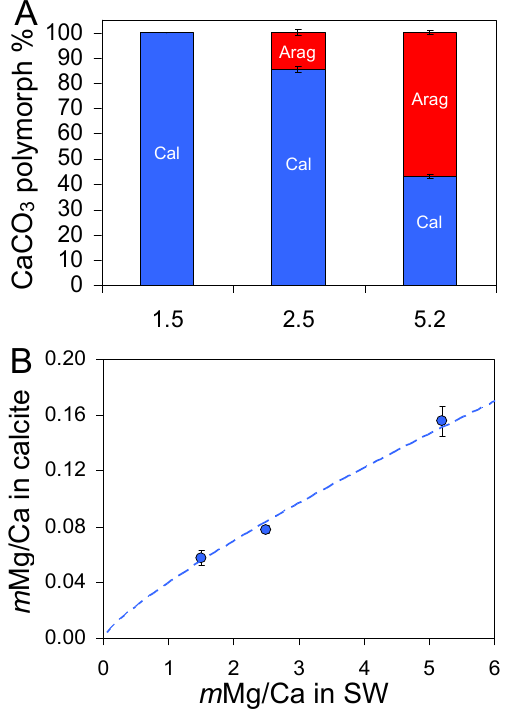
Fig. 28. Mineralogy and geochemistry of CaCO 3 precipitated within biofilms grown in the three experimental seawaters (Ries et al., 2008). (A) Relative abundance (mole-%) of calcite (blue) and aragonite (red) within biofilm CaCO 3 , determined by pow- der X-ray diffraction. (B) Mg/Ca of calcite precipitated within biofilms, determined by powder X-ray diffraction and energy dispersive spectrometry. Mg fractionation algorithm (dashed curve) calculated using least squares regression is defined as Mg/Ca C =0.0397Mg/Ca sw0 . 811 ( R 2 =0.99). Error bars represent un- certainty due to instrument error and specimen variation. From Ries et al. (2008).